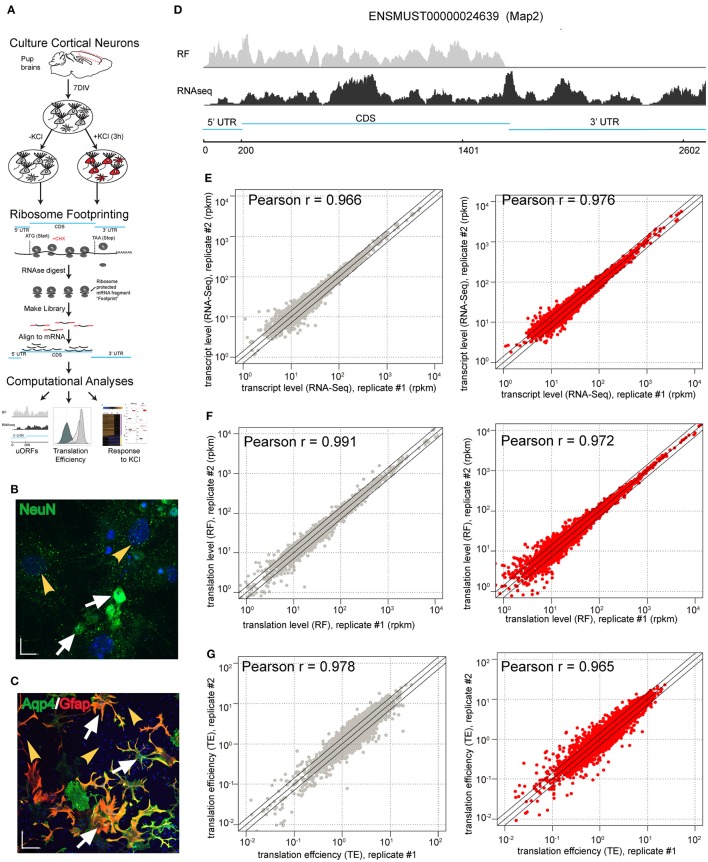
Ribosome footprinting of primary cultures is reproducible. (A) Illustration of the experimental design. Primary cultures were derived from mouse brains, matured for 7 days, then replicate cultures were exposed to depolarizing stimuli. Parallel RNAseq (not shown) and RF were conducted to measure transcript abundance and ribosomal occupancy of mRNA, respectively. RF entails harvesting cycloheximide (CHX)-stalled ribosomes, then digesting with RNAse I all mRNA except fragments physically protected by ribosomes. Libraries were prepared from protected fragments and aligned to the transcriptome, enabling downstream computational analyses. (B,C) 7-day primary cultures containing a mixture of neurons and glia. (B) Immunostaining for NeuN confirms the presence of neurons (white arrows) as well as non-neuronal cells (yellow arrowheads). (Blue is DAPI staining for nuclei; Scale bar = 17 μM) (C) Double immunostaining for Aqp4 and GFAP reveals astrocytes (white arrows) and putative non-glial cells (yellow arrowheads). (Blue is DAPI staining for nuclei; Scale bar = 70 μM). (D) Screenshot of RNASeq read depth in counts per million (CPM), showing fragments covering the entirety of a representative mRNA (bottom), and RF read depth, showing coverage only of CDS and 5'UTR (top) using Map2 gene. (E–G) Scatterplots comparing the replicate cultures show high levels of reproducibility for (E) transcript levels, (F) RF densities as well as (G) TE in both untreated (gray) and KCl-treated samples (red) (all Pearson r > 0.96).